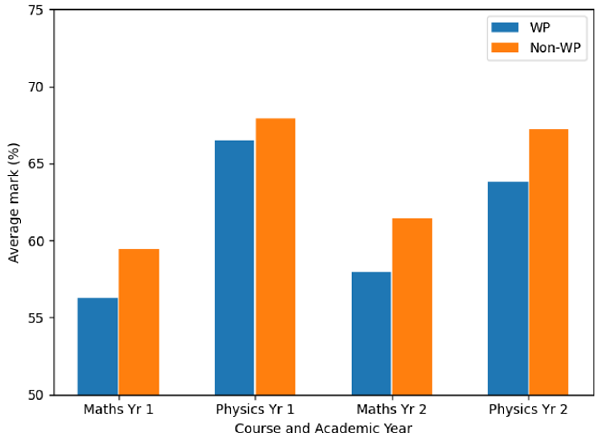
FIG. 8. Academic performance of WP and non-WP first year entry students in first and second academic year mathematics